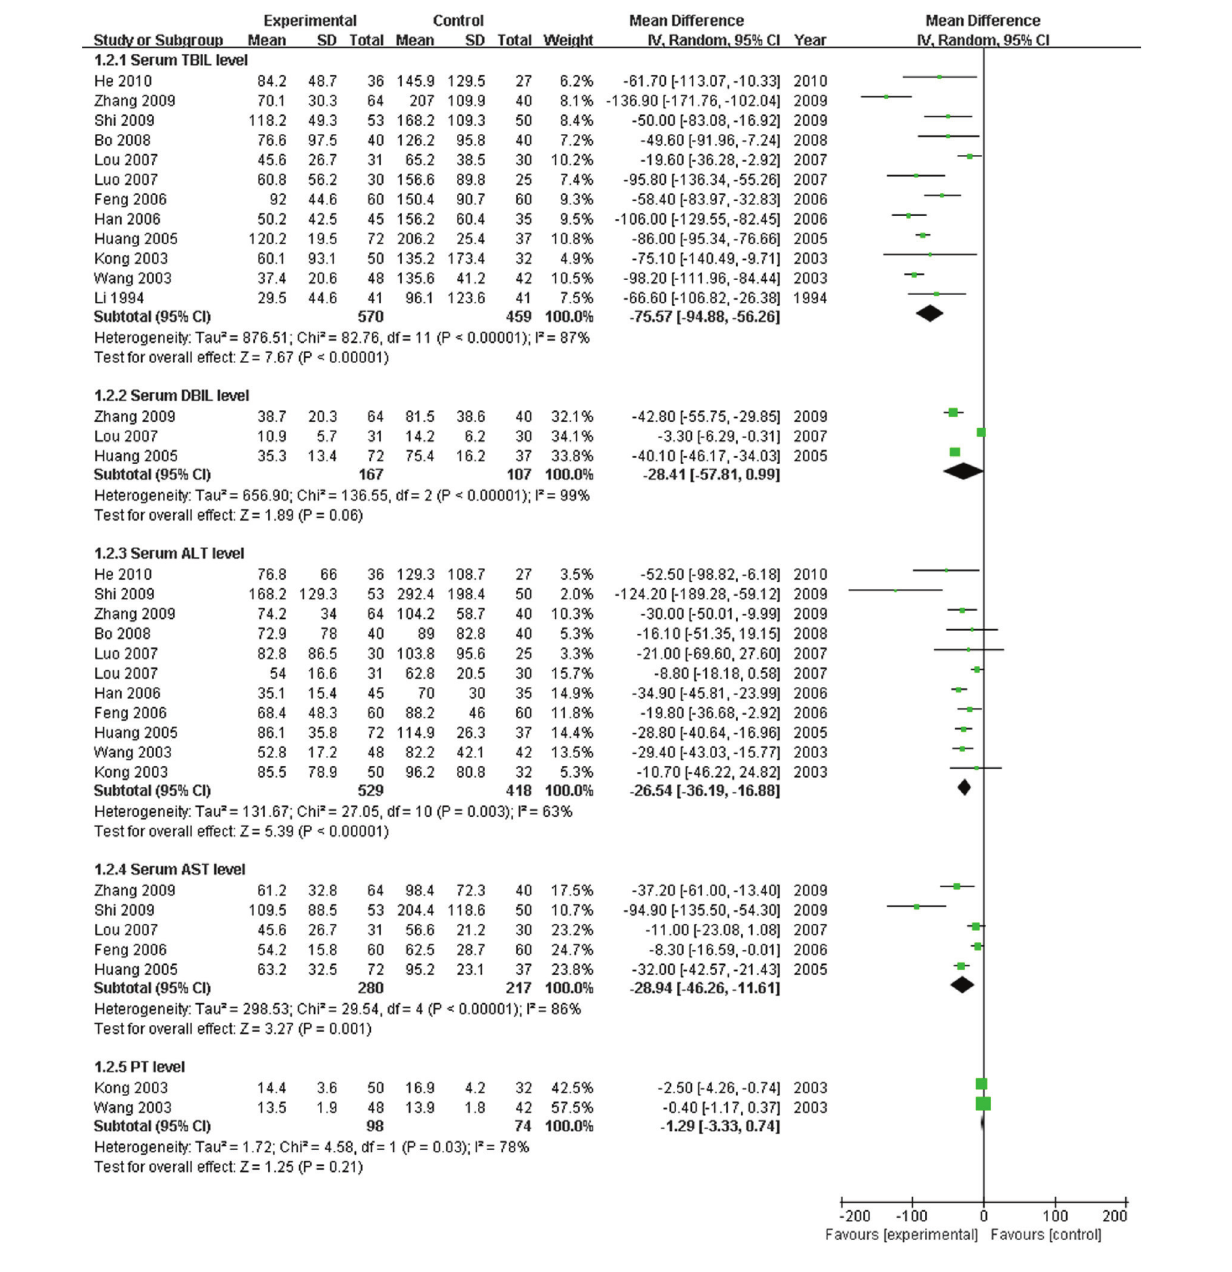
FIGURE 5 | Forest plot of TBIL, DBIL, ALT, AST, and PT in treatment. (1) Study item displayed as first author with the publication year. (2) Subgroups were divided by indices of TBIL, DBIL, ALT, AST, and PT. (3) I-squared and P are the criterion of the heterogeneity test, (cid:7) pooled mean difference, — (cid:4) — mean difference, and 95% confidence